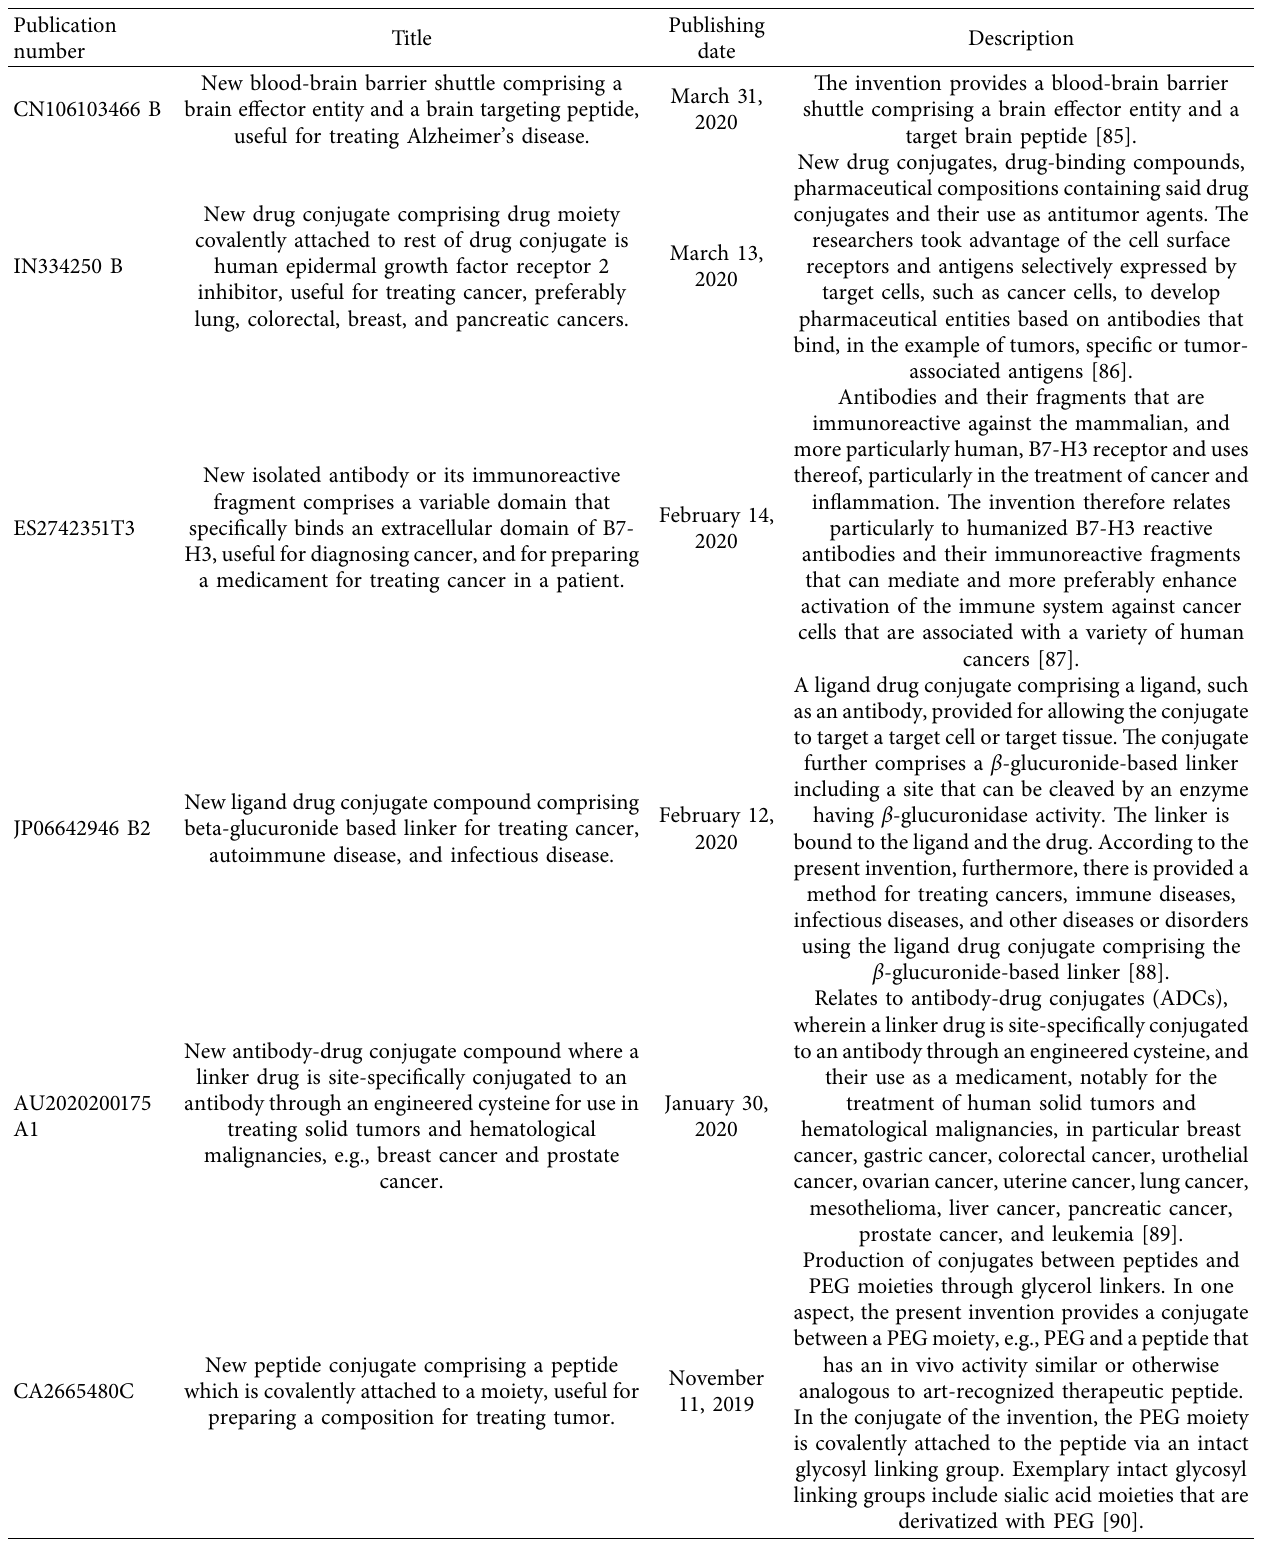
Table 1: Description of some patents published between 2019 and